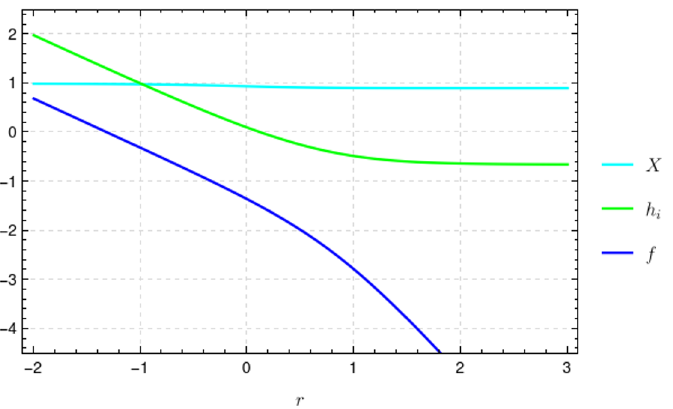
Figure 3 . Numerical interpolation between the AdS 6 and AdS 2 fixed point. The details of the numerical analysis are explained in appendix B.3. Again, g is given by g = − f +log X and we have assumed h = h along the 1 2